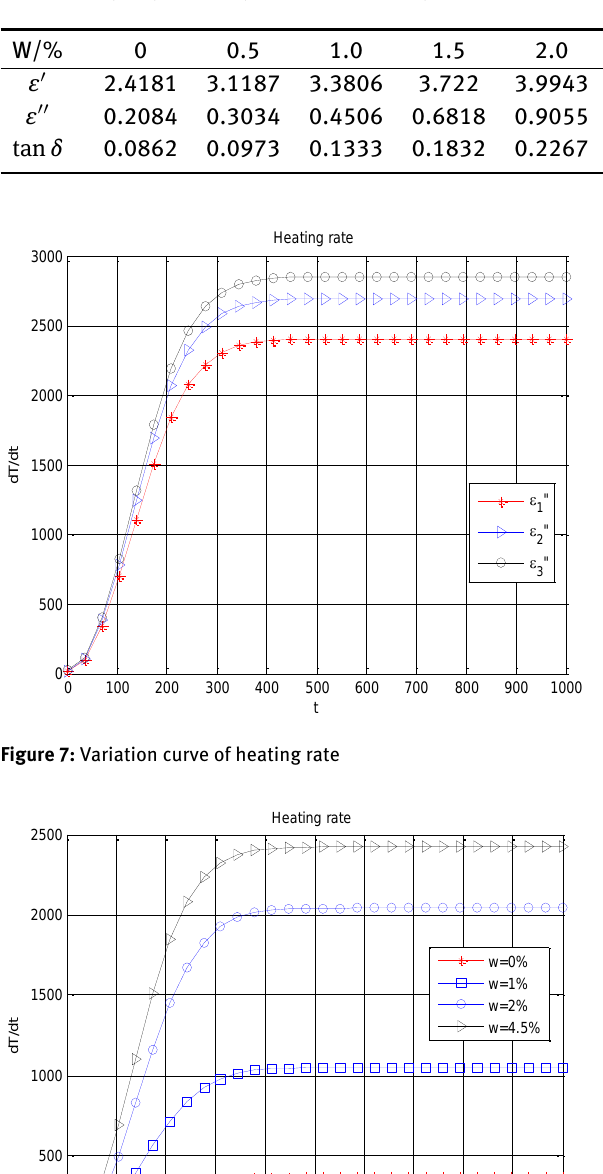
Table 2: Complex permittivity of sodium chloride particles at different water content at 2.45 GHz [25]